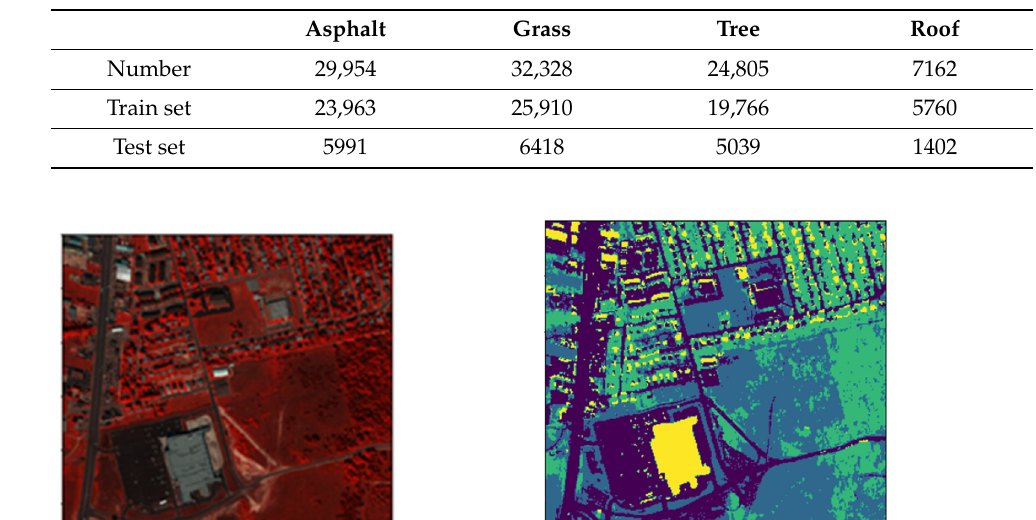
Table 1. Train and test sets of the dataset.